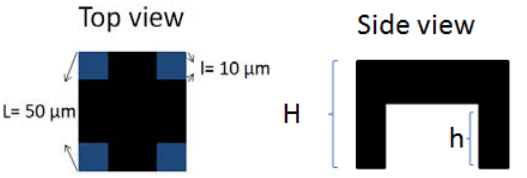
Figure 2. Platform thermal insulation structure as designed.